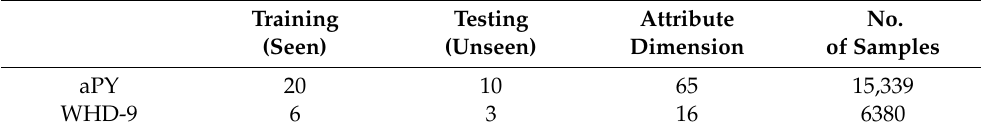
Table 2. Dataset